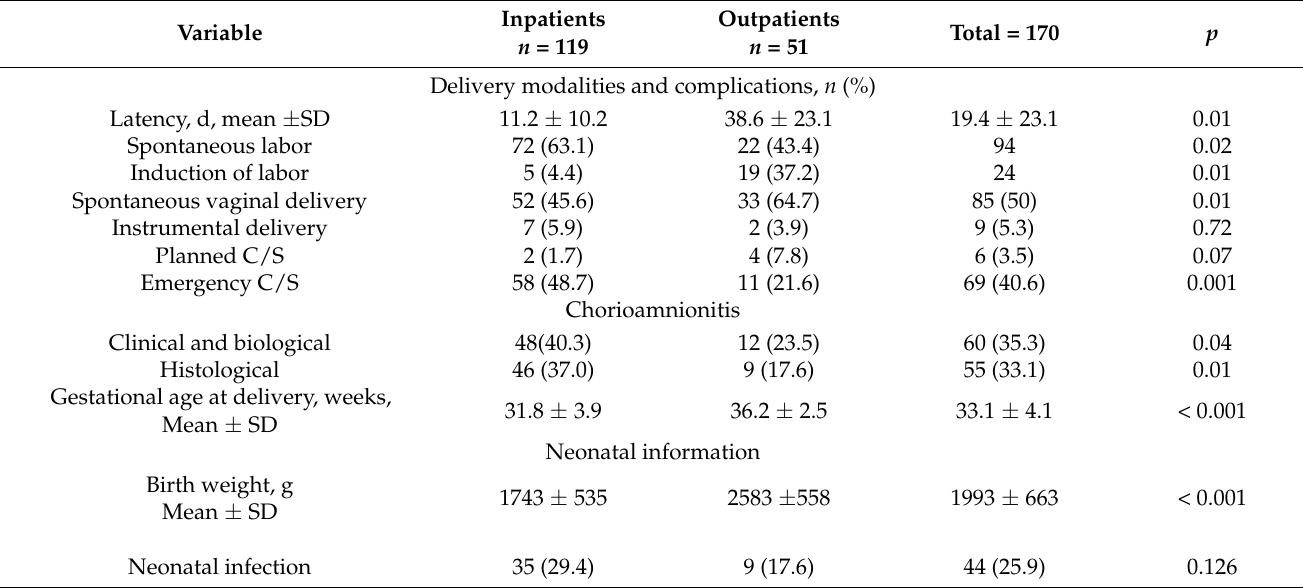
Table 6. Inpatient and outpatient